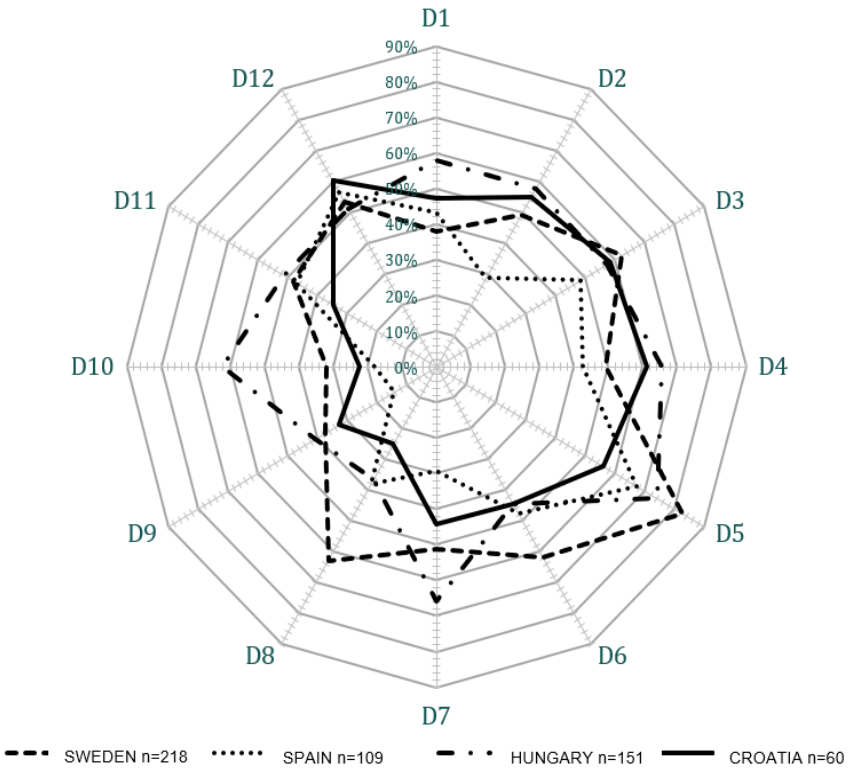
Figure 2. Positive safety culture perception for each HSOPSC dimensions by country.